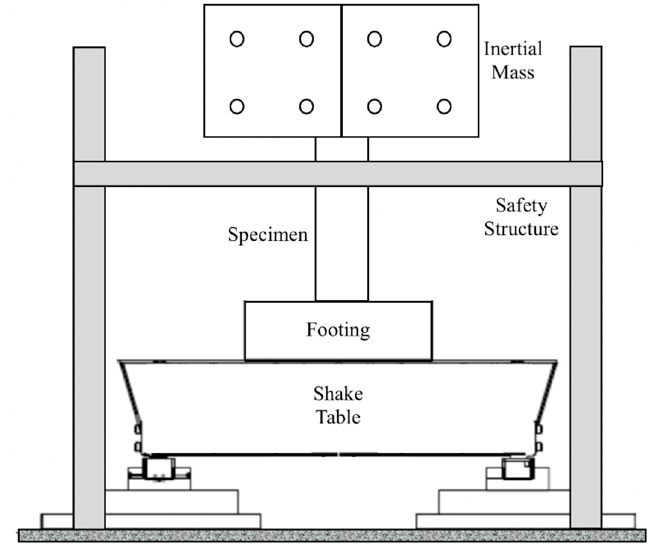
Figure 3. Representation of an inertial mass with safety structure outside the shake